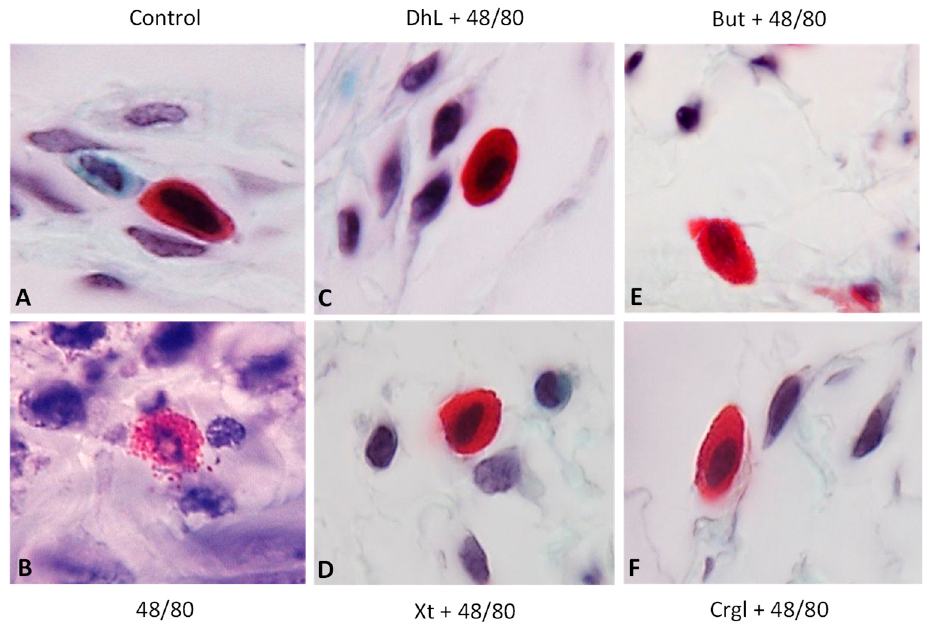
Figure 5. Paraffin sections (6 µ m) of gastric walls stained by safranin. Representative mast cells can be seen. ( A ) Control; ( B ) compound 48/80; ( C ) DhL + compound 48/80; ( D ) Xt + compound 48/80; ( E ) But + compound 48/80; ( F ) Crgl + compound 48/80. ×